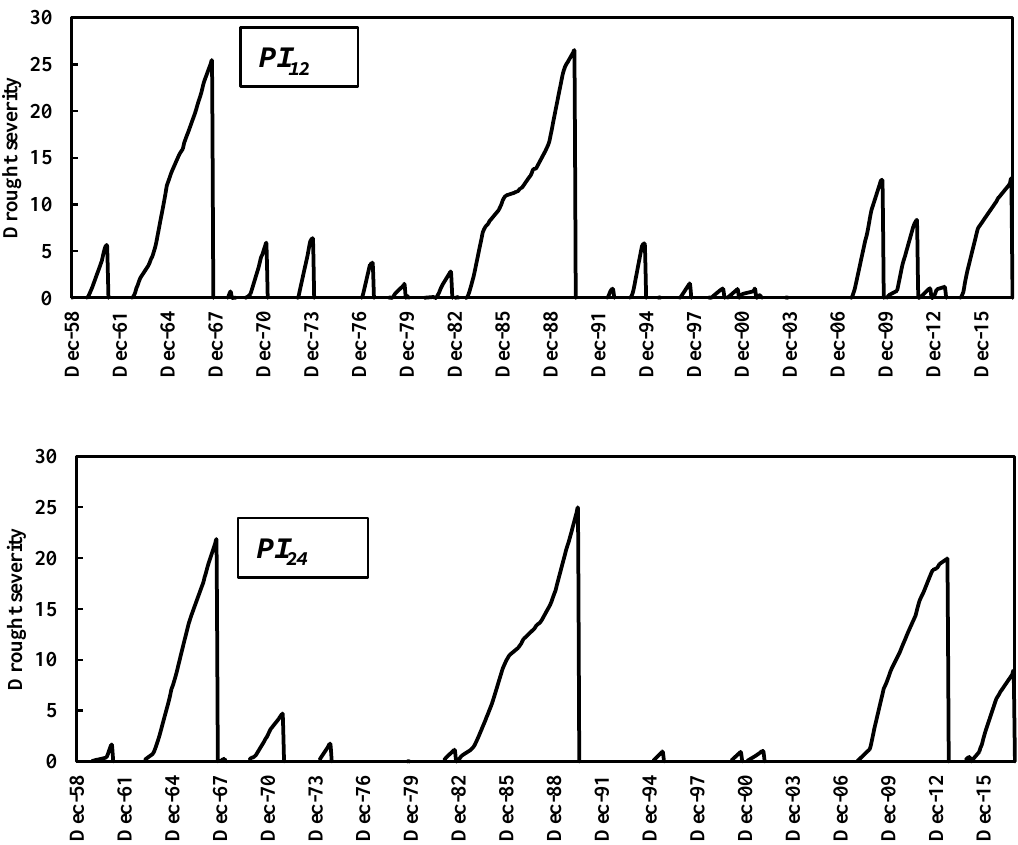
Figure 6. Cumulative drought severity versus time at 12- and 24-month timescales.